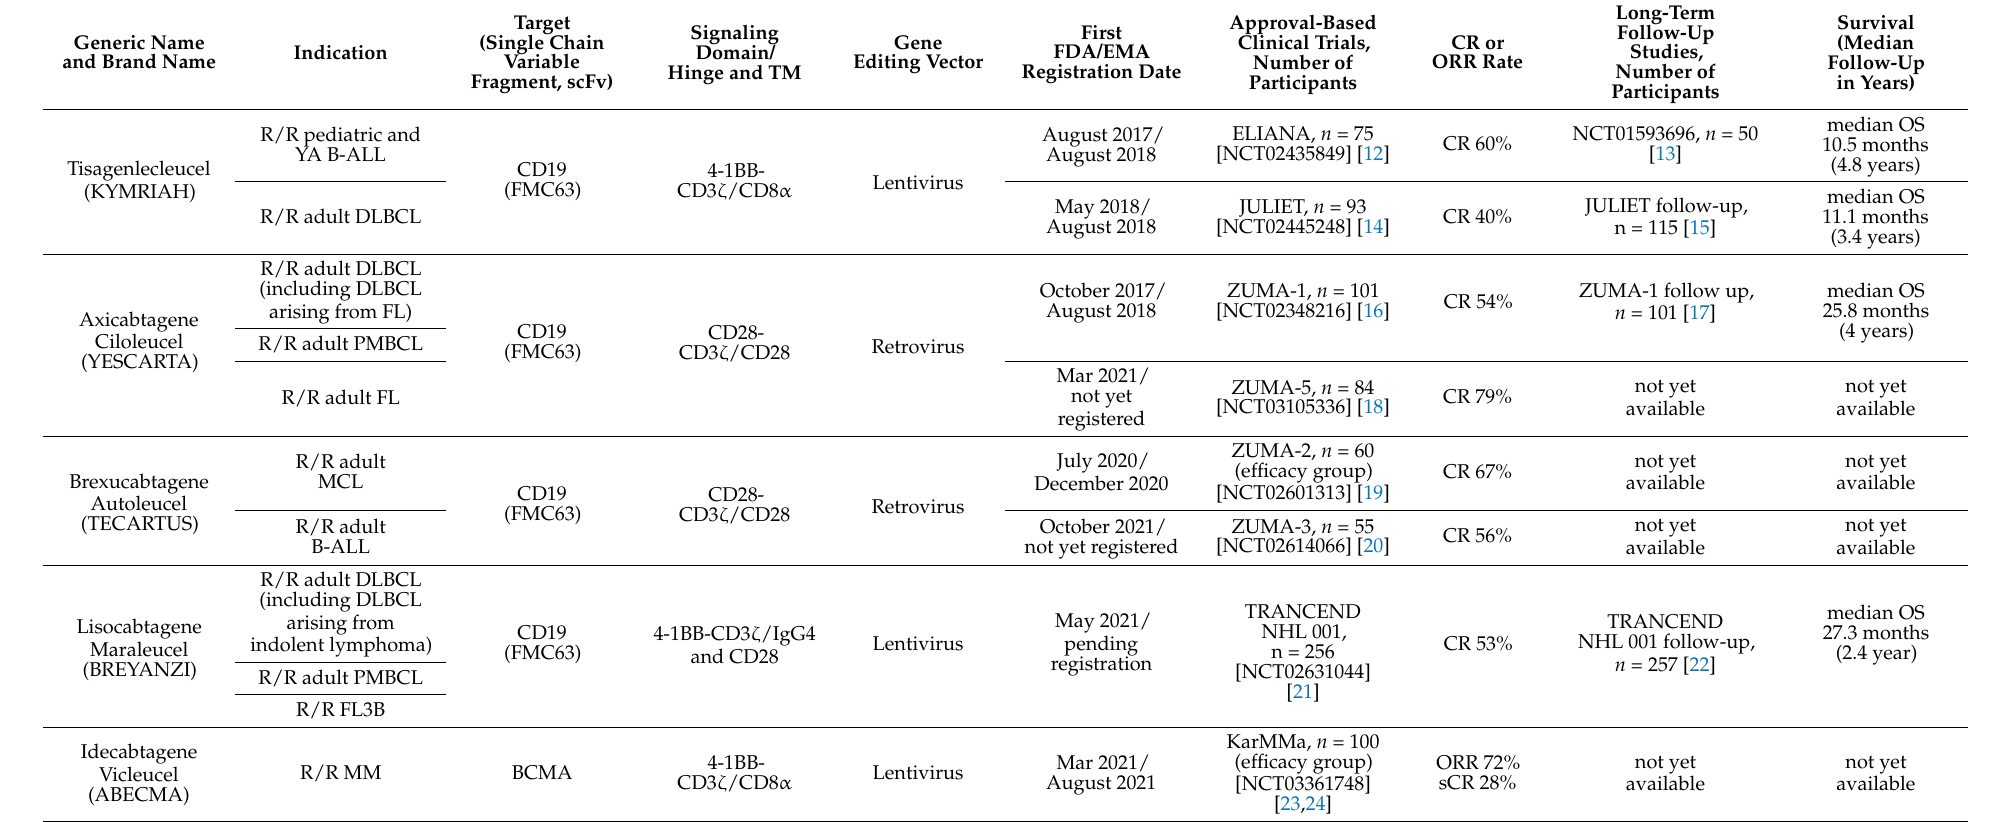
Table 1. Clinically approved CAR-T therapies in B cell and plasma cell-derived